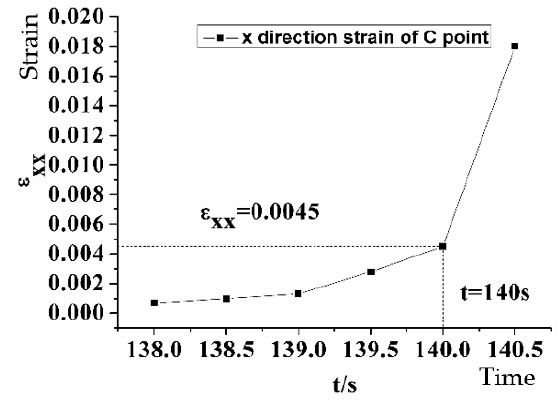
Figure 9. X-direction strain–time relationship at point C (loading rate = 0.1 MPa/s).